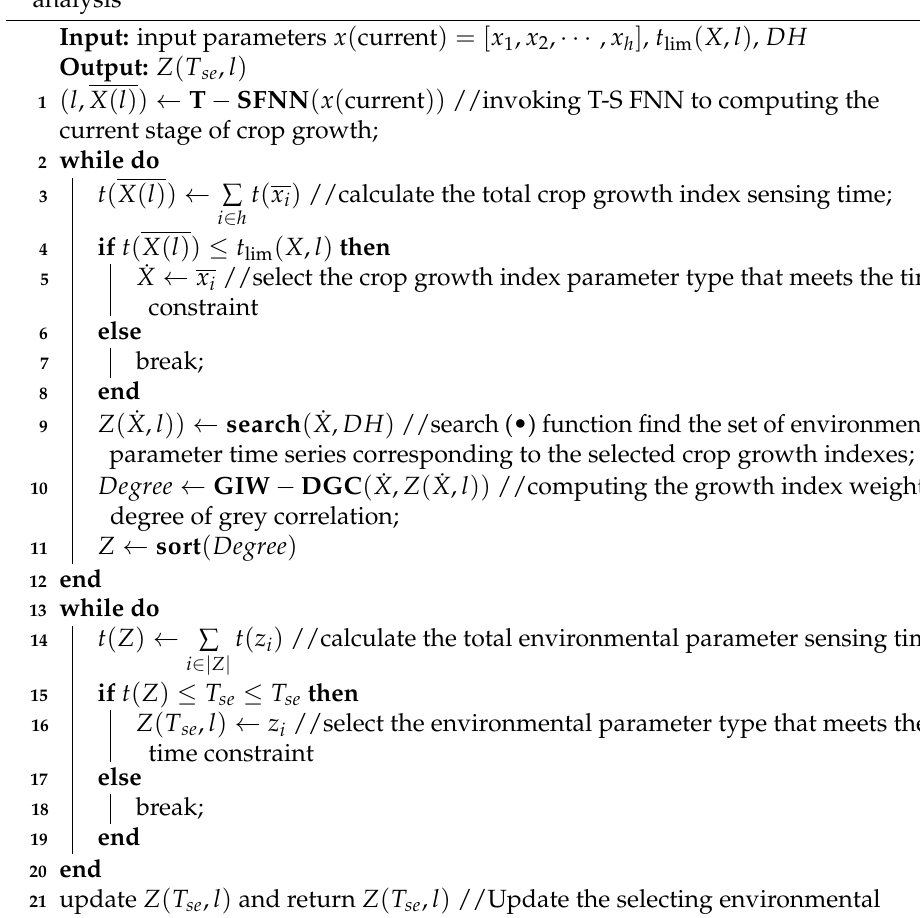
Algorithm 1: Environmental parameter selection based on grey correlation